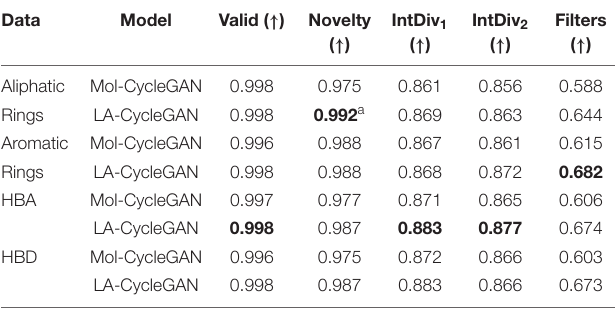
TABLE 4 | Performance evaluation of model on generating molecules. Data